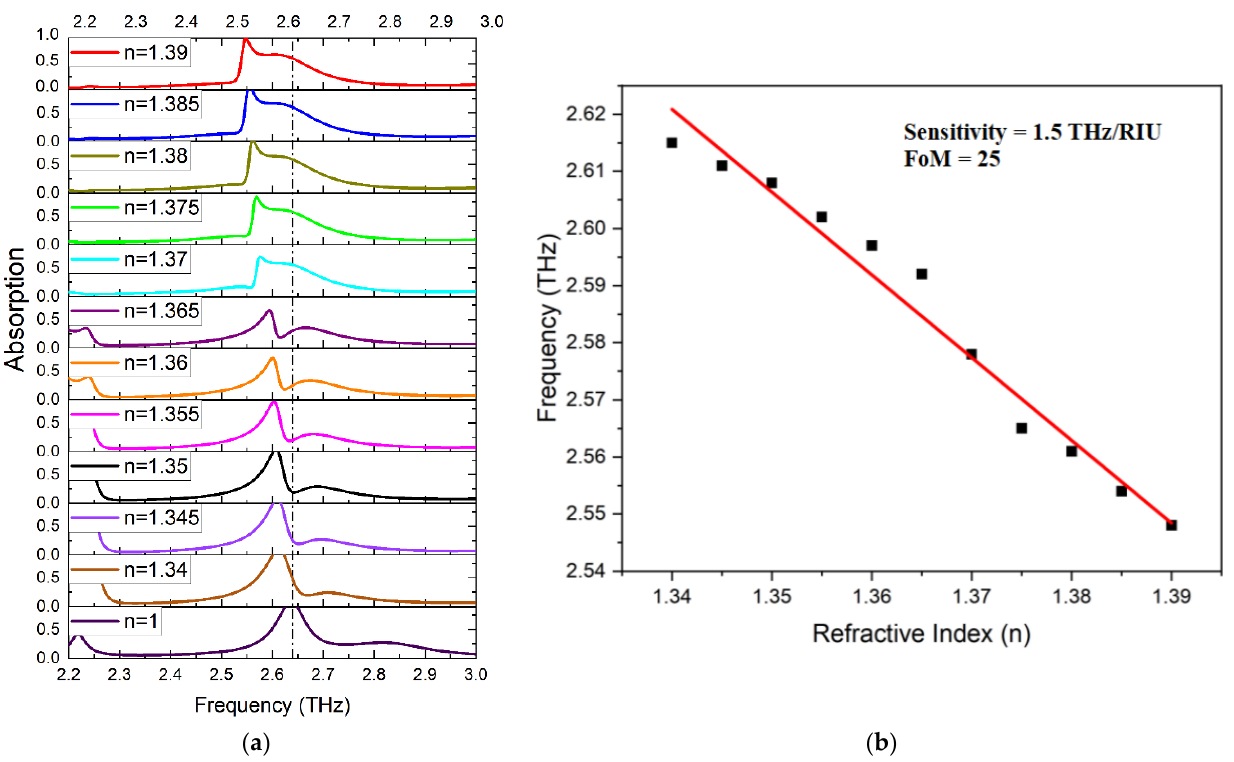
Figure 6. ( a ) Absorption spectra for different refractive indexes; ( b ) plot of the resonance frequency with respect to the